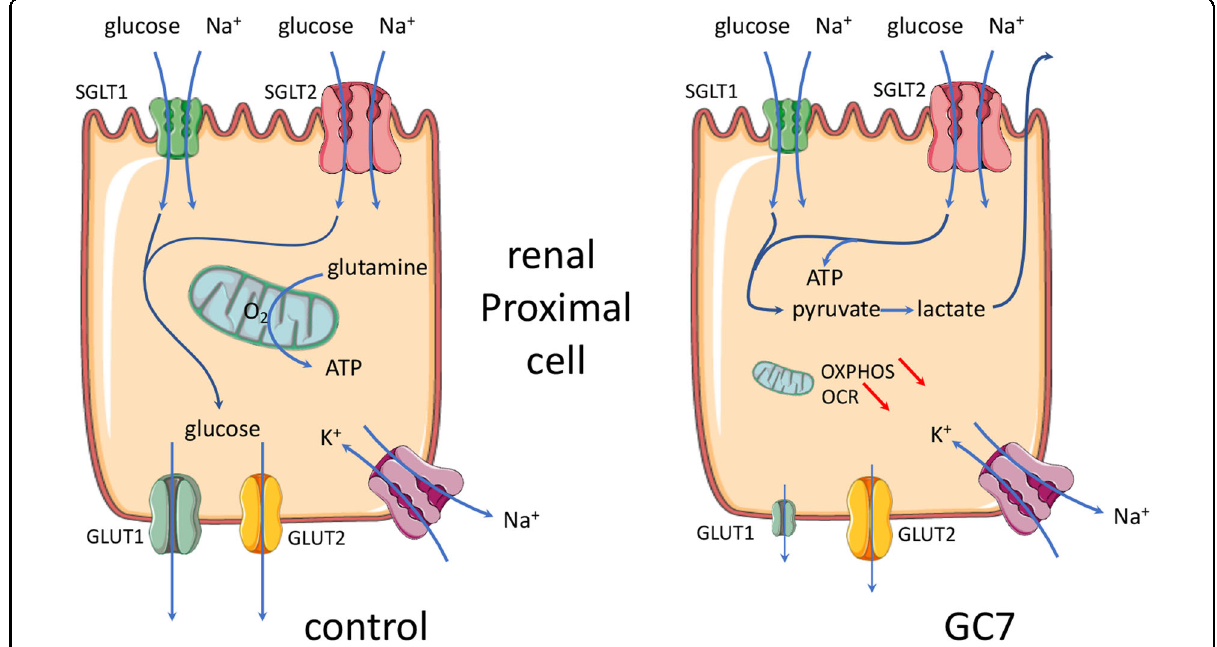
Fig. 8 Schema of GC7 effects on glucose handling in proximal cells. Schematic representation of normal and GC7-treated proximal cells regarding the glucose handling. GC7 represses the oxidative phosphorylation mediated by the mitochondrial function and enforces the cell to shift toward a glycolytic pathway to maintain energetic status. The apical fl ux of glucose mediated by the SGLT2 transporter is thus necessary to feed this pathway and cell survival becomes then largely independent of ambient oxygen. This reversible shift is accompanied by a strong inhibition of the glucose reabsorption through the basolateral membrane due to the downregulation of the facilitated transporter